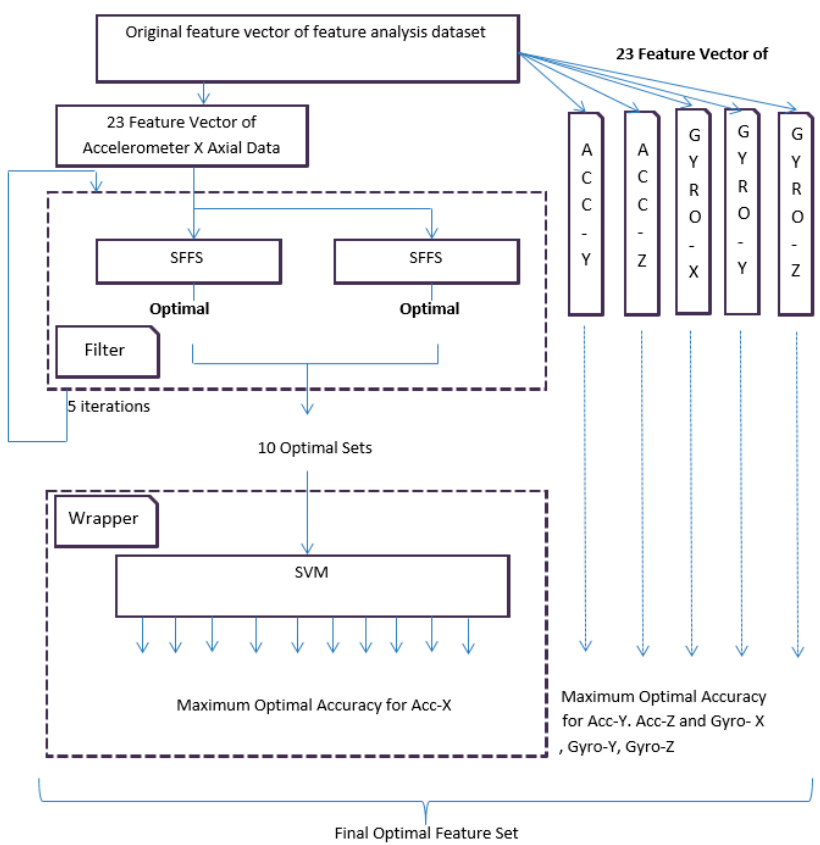
Figure 2. Overall block diagram of the proposed hybrid feature selection.